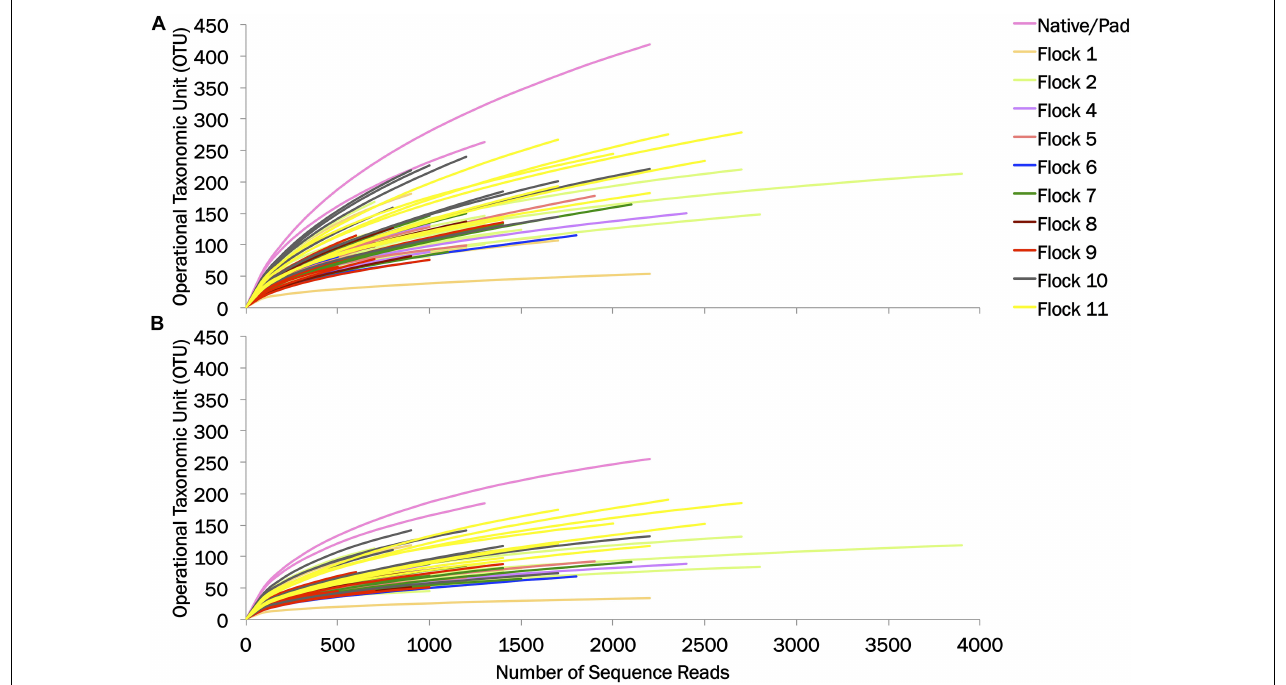
FIGURE 1 | Rarefaction curves of operational taxonomic units (OTU) at (A) 0.03 and (B) 0.10 genetic distances.